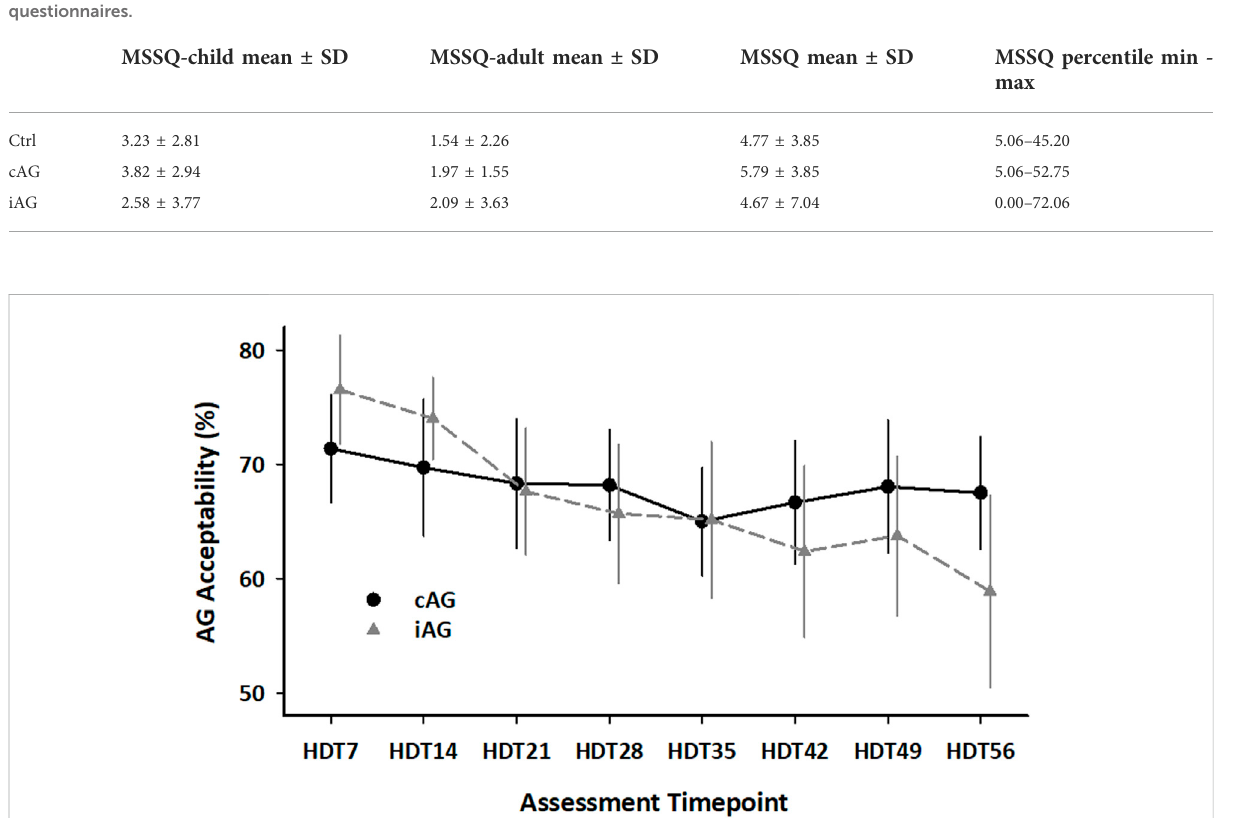
FIGURE 7 Average acceptability of the AG countermeasure measured in weekly intervals for the cAG and iAG subject groups (8 subjects per group). Mean ±